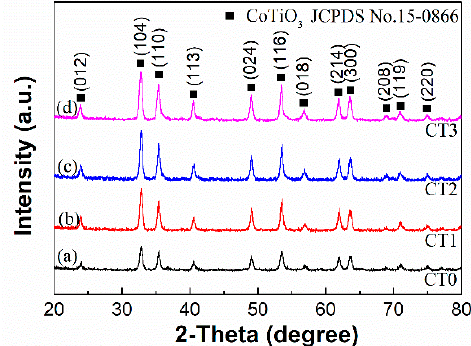
Figure 2. SEM images of the as-prepared products. ( a ) Sample CT0; ( b ) Sample CT1; ( c ) Sample CT2; ( d ) Sample CT3.